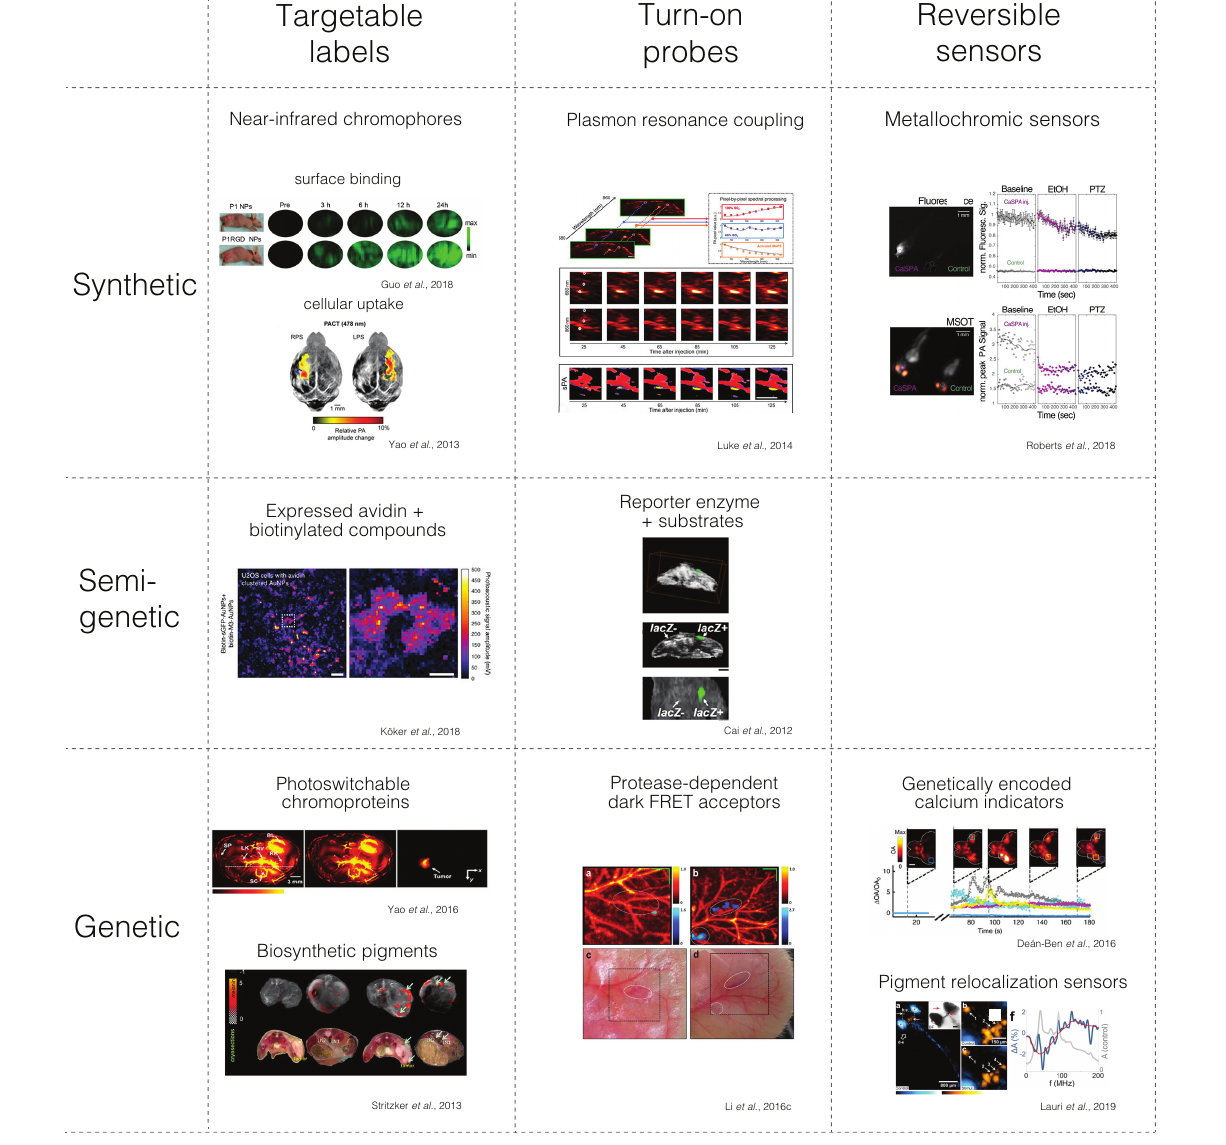
polymer nanoparticles, and other inorganic nanostructures (e.g., carbon